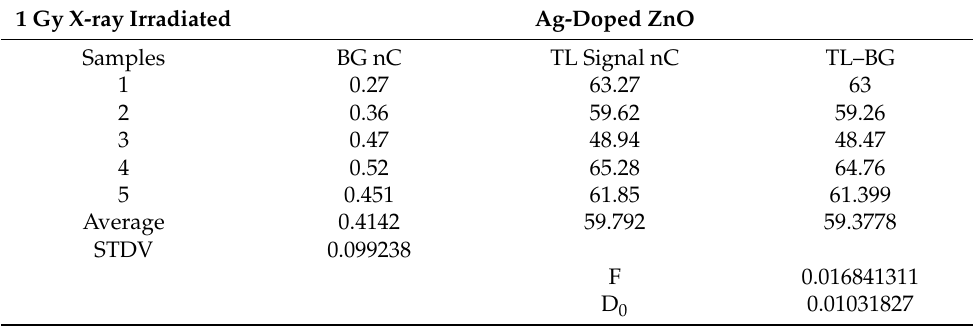
Table 2. The minimum detectable doses (MMD) for the Ag-doped ZnO thin film. 1 Gy X-ray